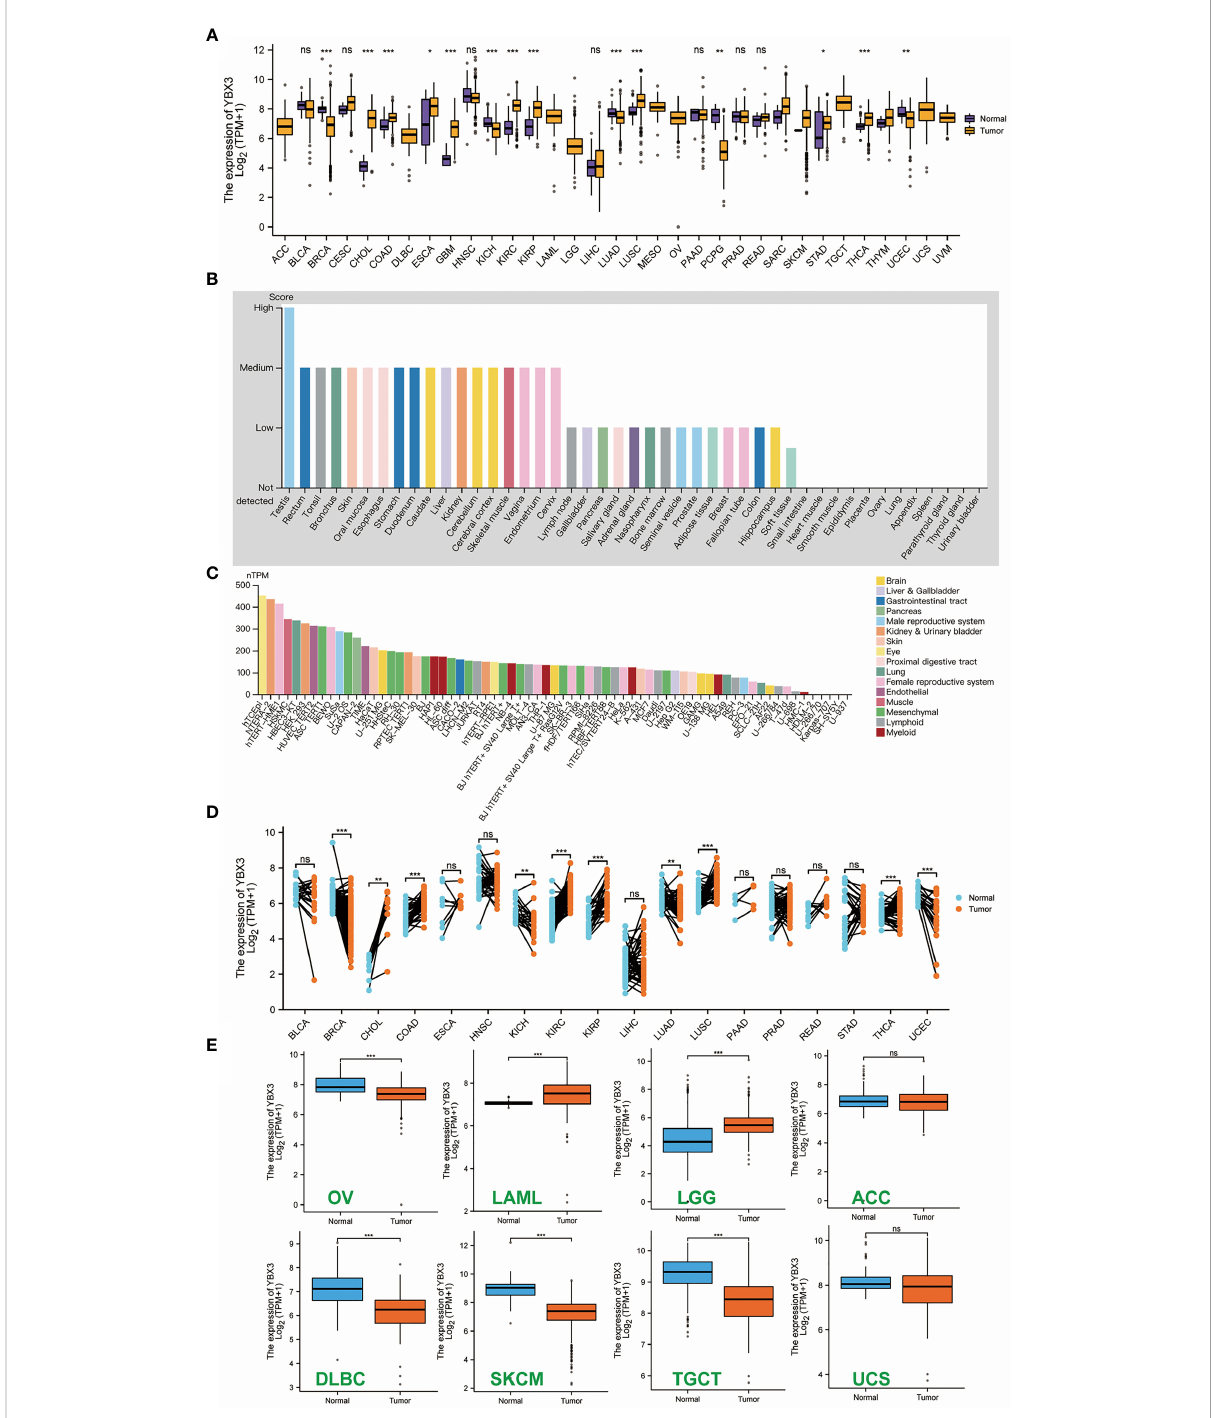
FIGURE 1 Expression level of YBX3 gene in diverse tumors, normal tissues, and cell lines (* p < 0.05, ** p < 0.01, *** p < 0.001). (A) YBX3 expression pro fi le in unpaired samples among pan-cancer. (B) YBX3 expression in different normal tissues. (C) YBX3 expression in diverse cell lines of different organs. (D) YBX3 expression in The Cancer Genome Atlas tumors and corresponding adjacent normal tissues in paired samples. (E) YBX3 expression in some cancers using data from GTEx databases as controls. ns, non-signi fi